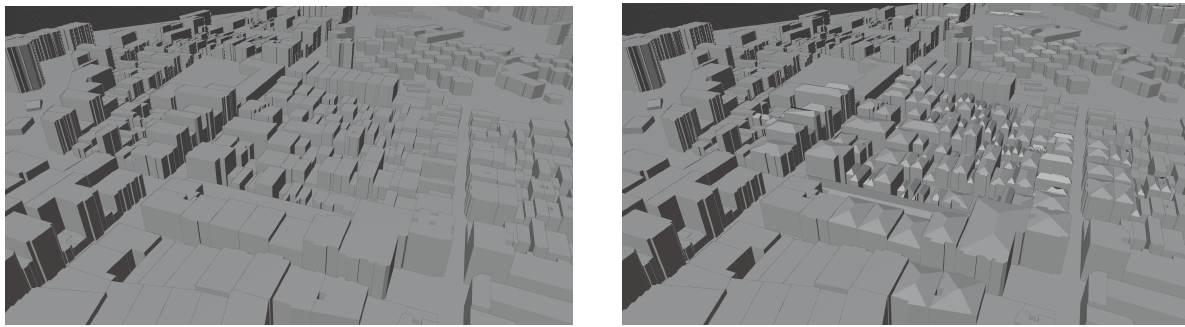
Figure 10. Barcelona area without inferred roofs ( left ) and with inferred roofs ( right